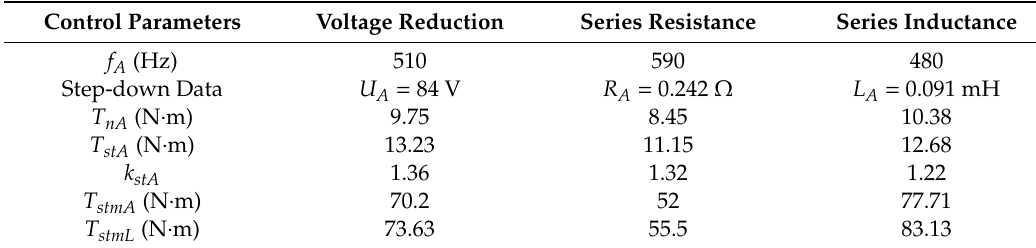
Table 3. Design data of low-frequency step-down starting.